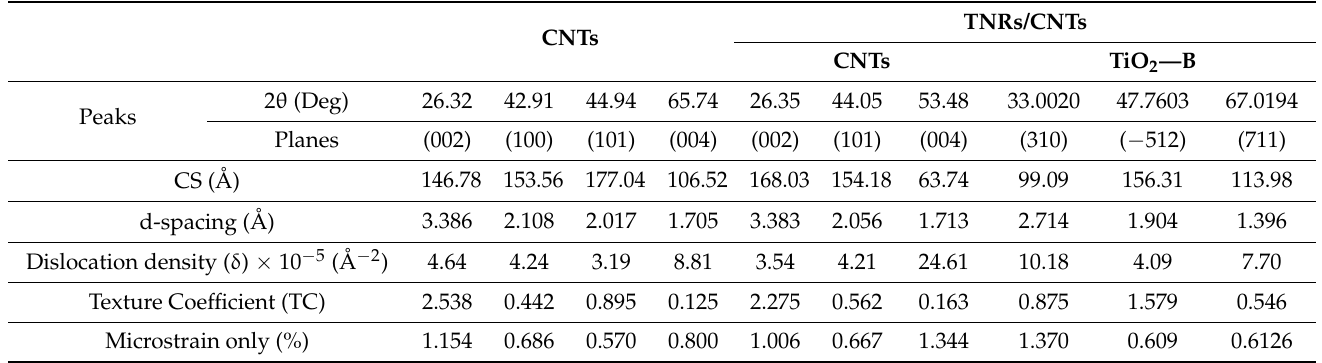
Table 1. The CNTs and nanocomposite’s crystallite sizes (CS), d-spacing, dislocation densities, texture coefficients, and strain. TNRs/CNTs CNTs CNTs TiO 2